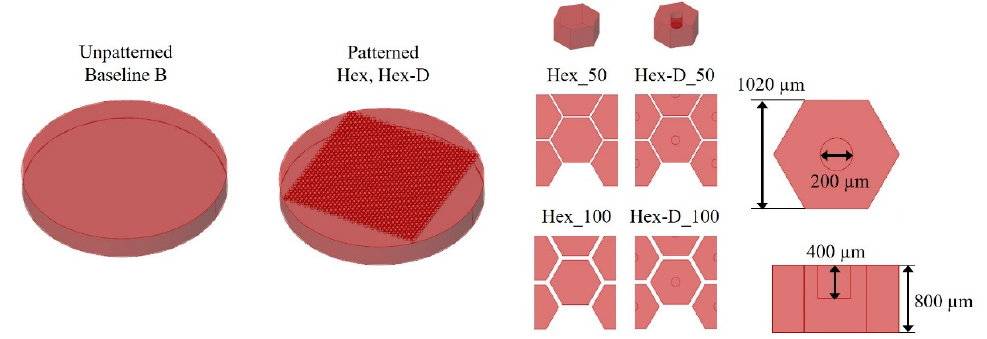
Figure 5. Samples employed for tribological tests and ensuing nomenclature.